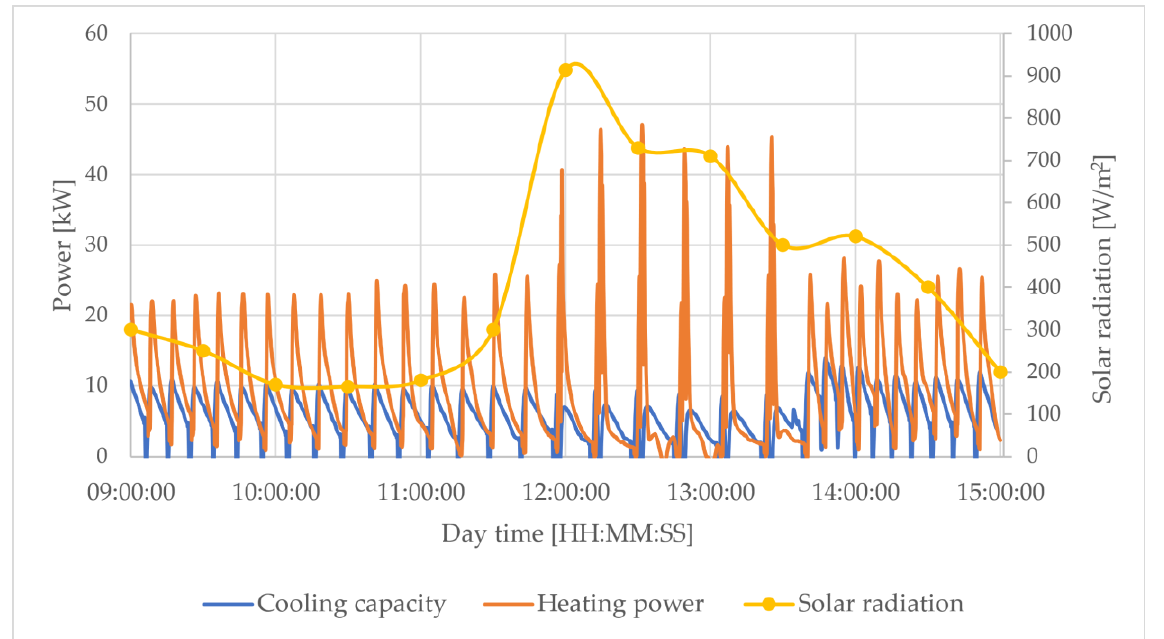
Figure 10. The fluctuation of heating and cooling power values over time for 8th July.